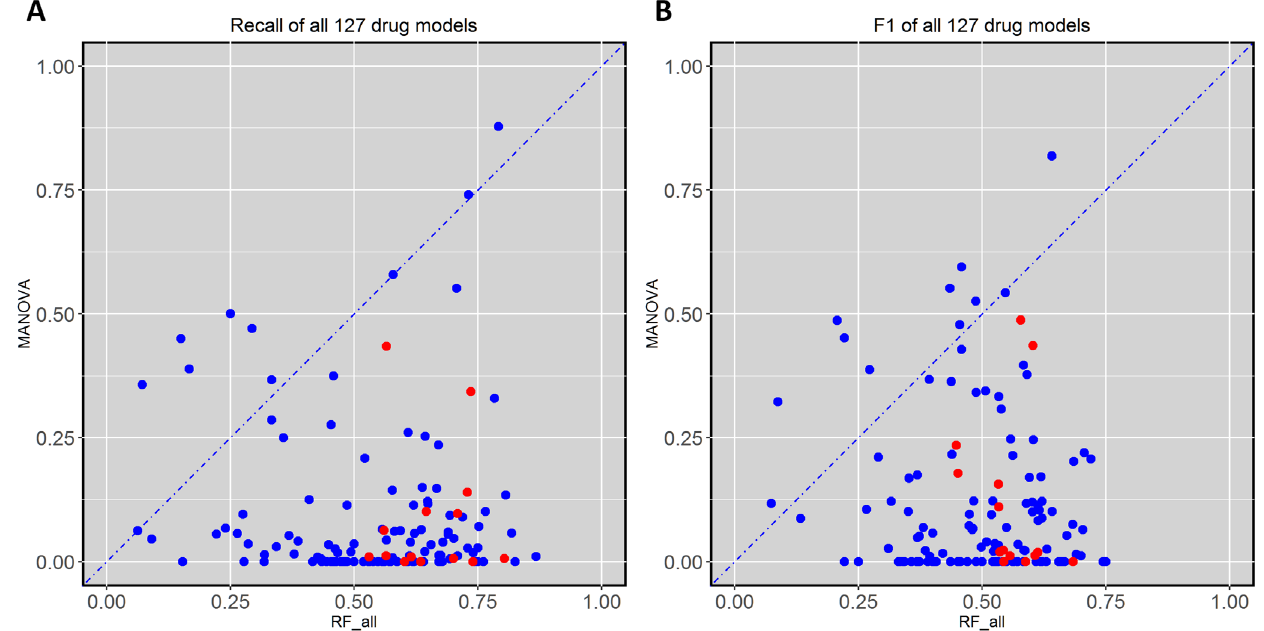
Figure 4. Test set recall and F-scores of single-gene and transcriptomic models across the 127 drugs. ( A ) Transcriptomic markers achieve much higher recall than single-gene markers in 117 of the 127 drugs. ( B ) Similarly, multi-gene markers achieve higher F-scores in 117 of the 127 drugs. In each plot, cytotoxic drugs are in red and targeted drugs are in blue. All cytotoxic drugs have better recall and F-scores by the Random Forest (RF) transcriptomic